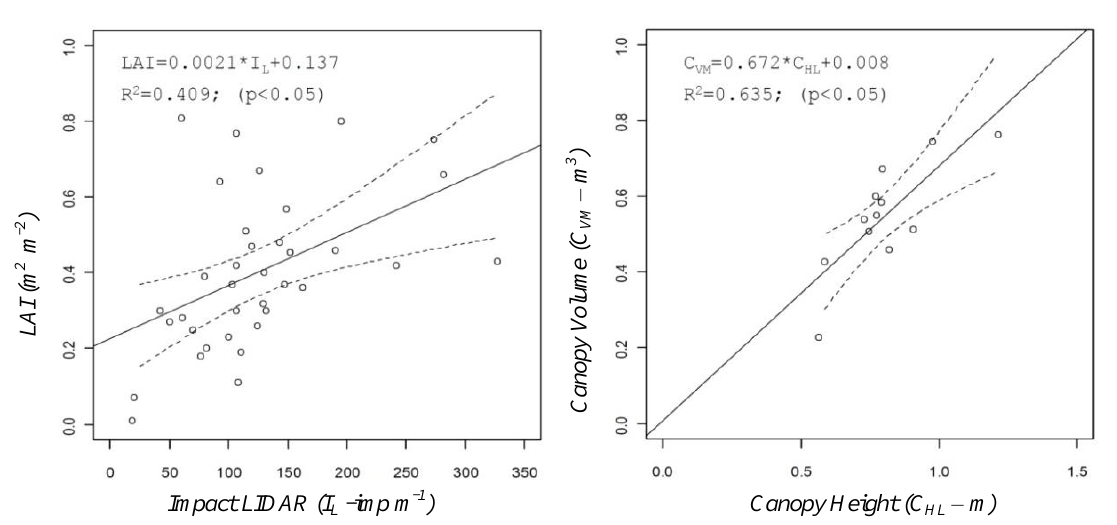
Figure 4. Relation between laser impacts obtained with LIDAR and LAI ( Left ). The correlation between canopy heights calculated with LIDAR and the canopy volume manually measured ( Right ) (published in [8], with permission of the editor of Sensors